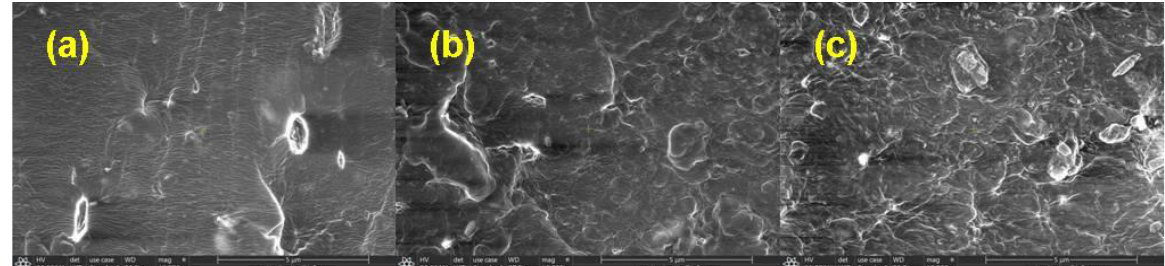
Figure 8. SEM micrographs of mixture C at magnification of 10,000: ( a ) non-irradiated and irradiated at ( b ) 150 kGy and ( c ) 450 kGy.